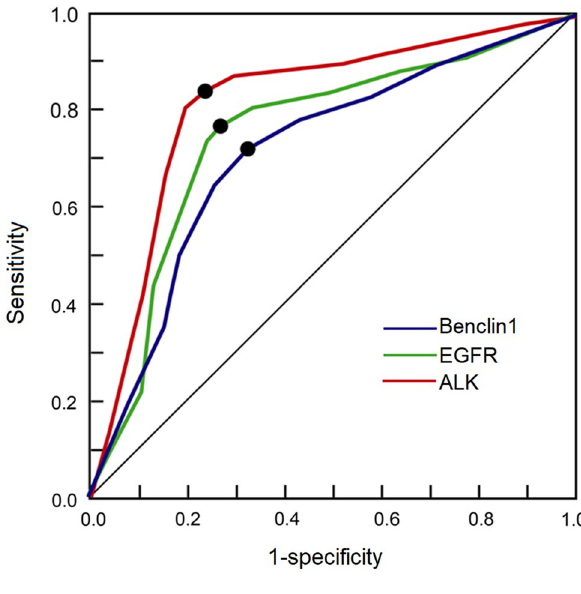
Table 5 ROC analysis of Beclin 1 expression, EGFR and ALK mutations to predict postoperative PFS in